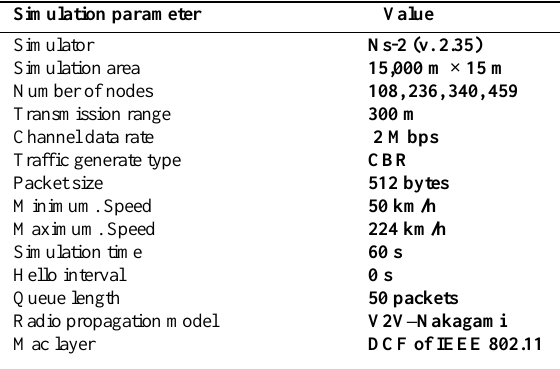
Table 2. Simulation